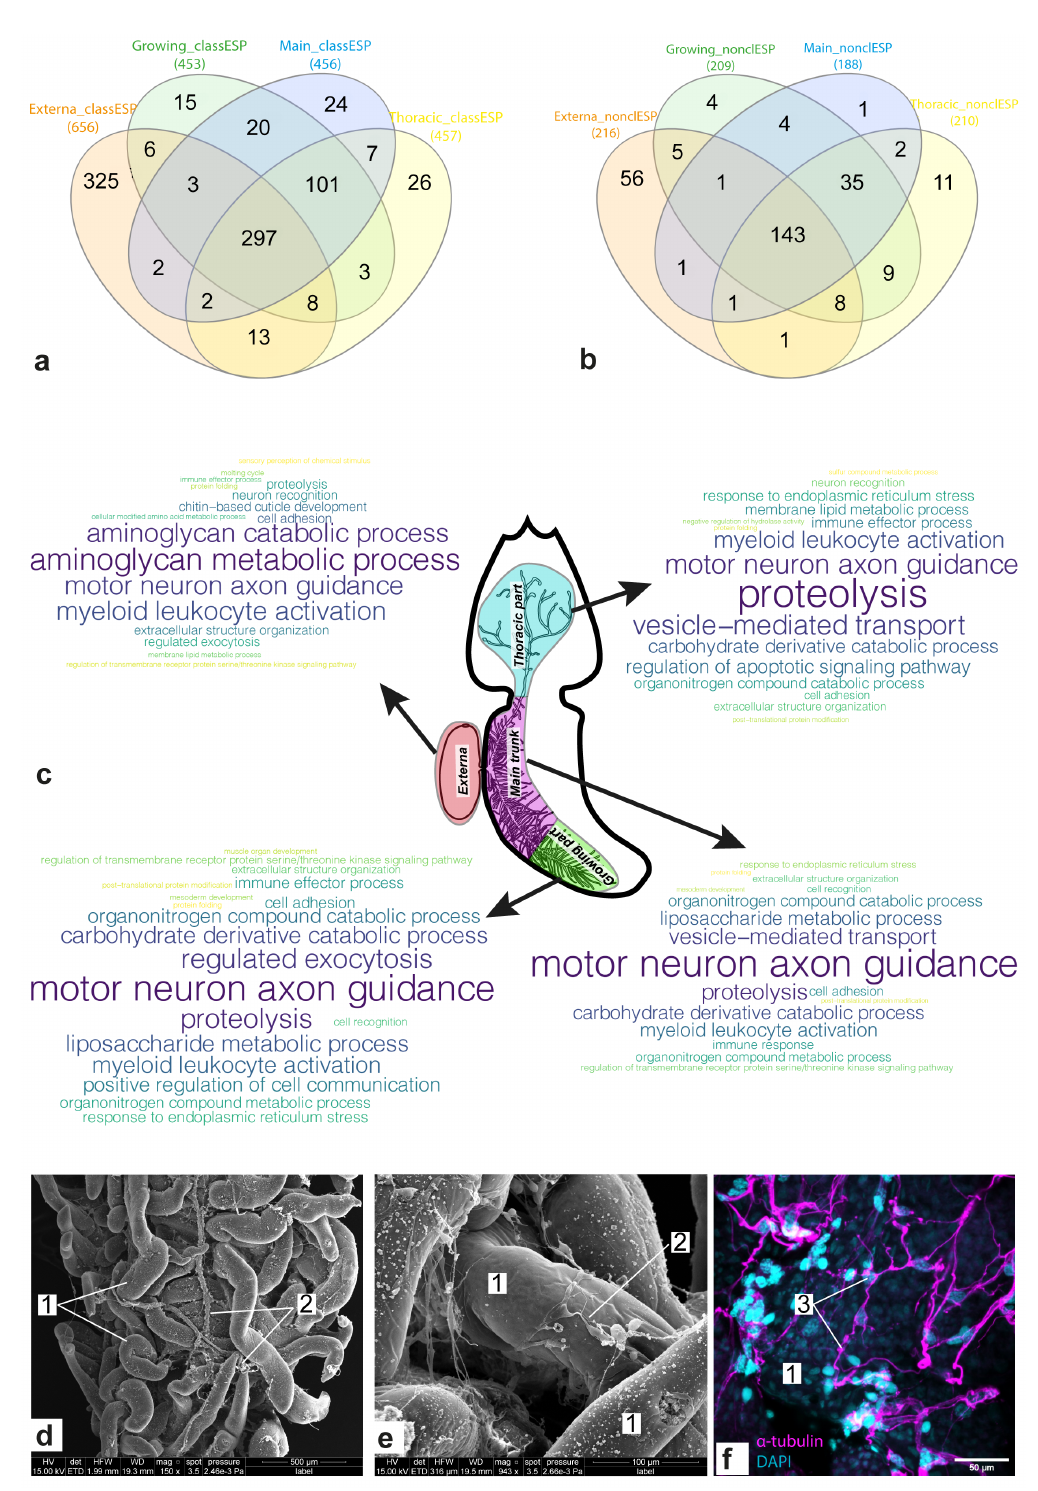
Figure 3. Gene set enrichment analysis (GSEA) results for the identified sets of potential excretory/secretory proteins (ESP). ( a , b ) Venn diagram for sets of potential “classical” ( a ) and “non-classical” ( b ) ESP encoded by genes from molecular signatures of the body parts. ( c ) Clouds of parental bioprocesses enriched by genes encoding “classical” ESP. Most often the bioprocess was found in the list of enriched bioprocesses, the larger the word size. ( d – e ) Scanning electron microscope (SEM) photos of the interna of P. reticulata, 1 - rootlets; 2 – host tissues enlacing rootlets. ( f ) Confocal laser scanning microscopy (CLSM) photo of the interna of P. reticulata, scale bar 100µm, 3 - host tissues stained with antibodies against α-tubulin. Abbreviations: class/nonclassES – “classical” and “non-classical” ESP, respectively.